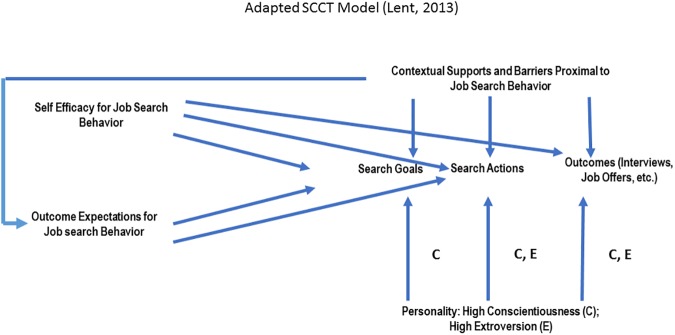
Adapted SCCT model.